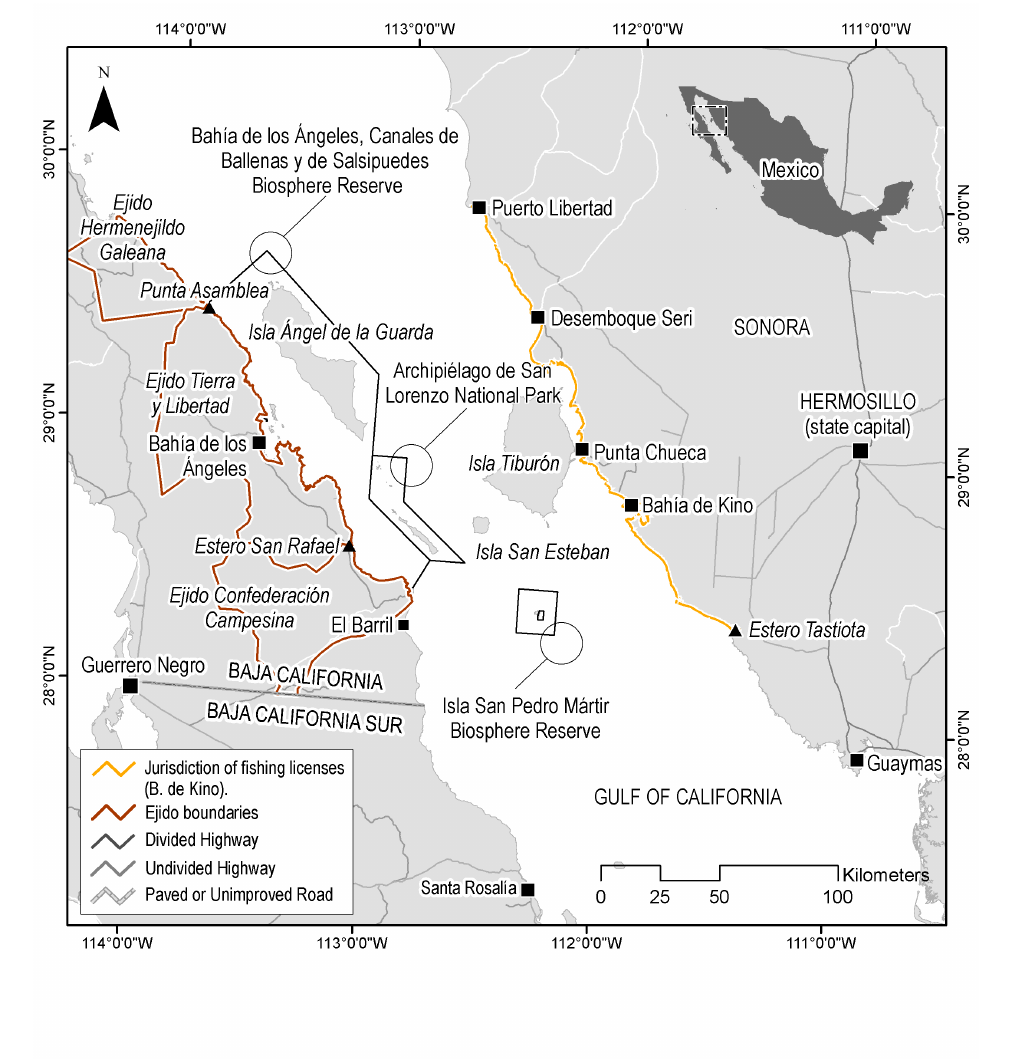
Fig. 1 . Map of the study area. The MPAs in the area are: Bahía de los Ángeles, Canales de Ballenas y de Salsipuedes Biosphere Reserve; Archipiélago de San Lorenzo National Park; and Isla San Pedro Mártir Biosphere